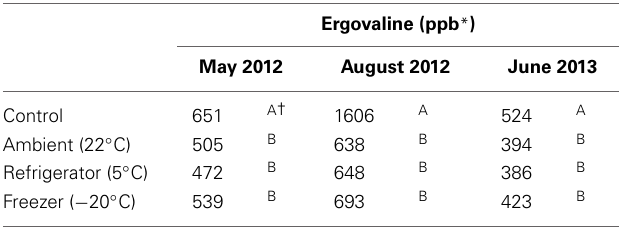
Table 2 | Ergovaline concentrations after 24h of storage at various temperatures for three harvests.